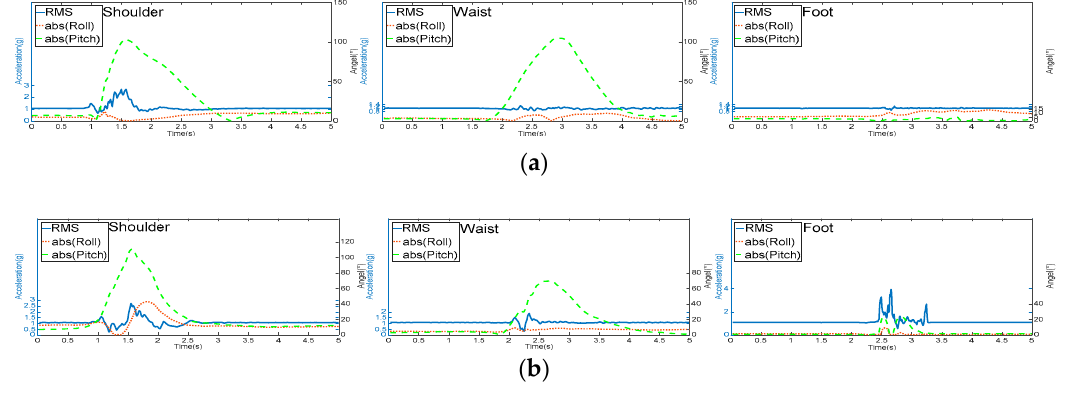
Figure 9. RMS and absolute value of roll and pitch distribution on the shoulder, waist, and foot during typical fall activities: ( a ) Backward fall ending up lying; ( b ) Forward fall ending up lying; ( c ) Lateral right fall ending up lying; ( d ) Lateral left fall ending up lying.